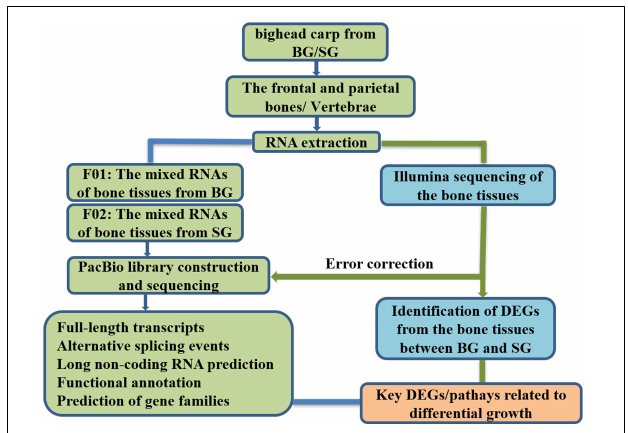
FIGURE 8 | The layout plan of the study design. BG is the abbreviation of big bighead carp, and SG means small bighead carp.